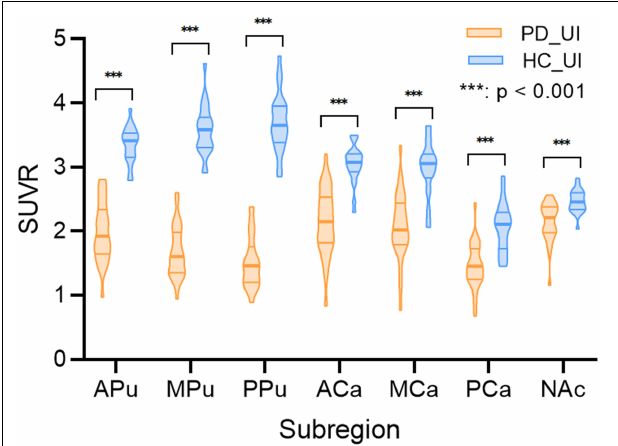
FIGURE 5 | Subregion [18F]-FP-DTBZ SUVRs in cohort UI. In the violin plot, the central mark indicates the median, and the bottom and top edges indicate the 25th and 75th percentiles. HC_UI, healthy control from UI scanner; PD_UI, Parkinson’s disease from UI scanner. Significance: *** p < 0.001 t -test